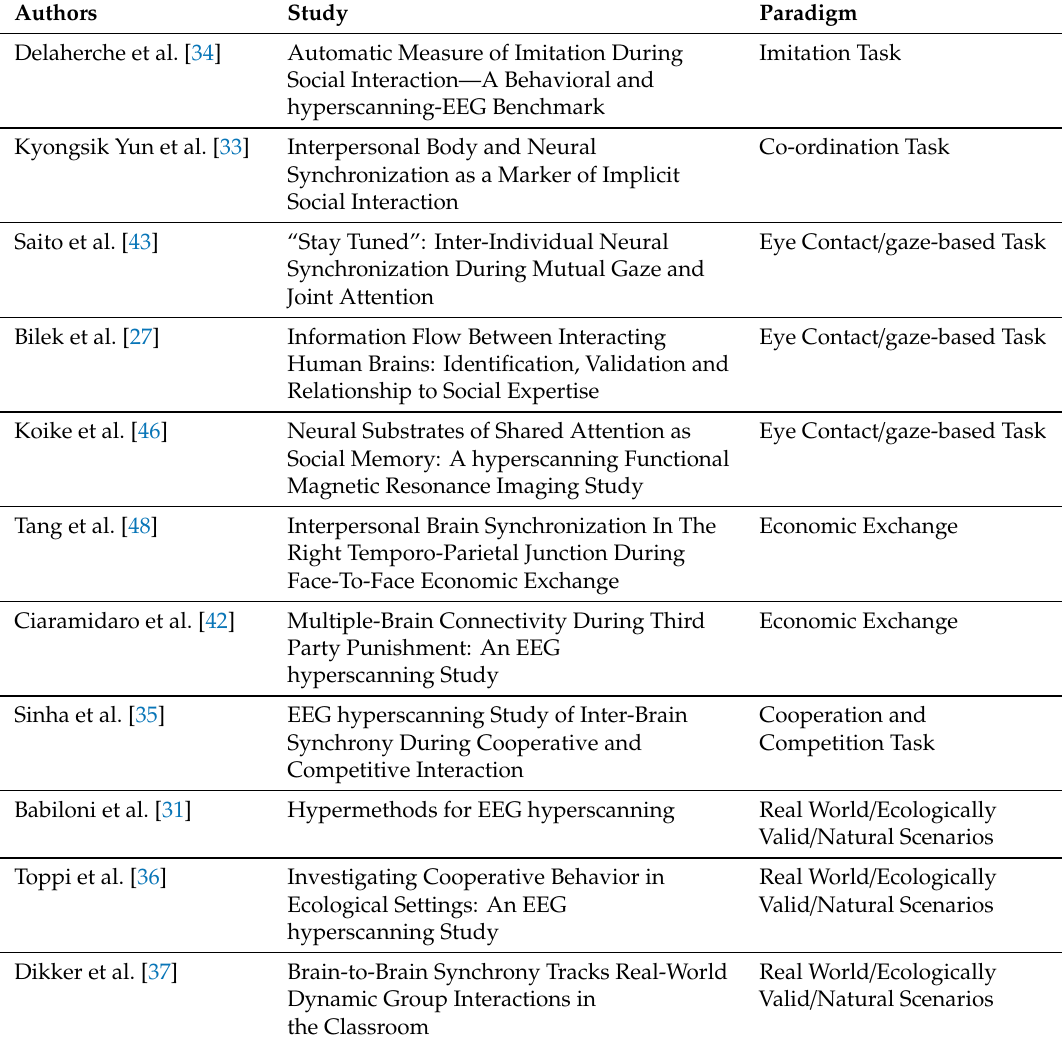
Table 2. A list of hyperscanning studies based on the study paradigm. The studies listed in the table reflect only a subset of those used for the purpose of the literature